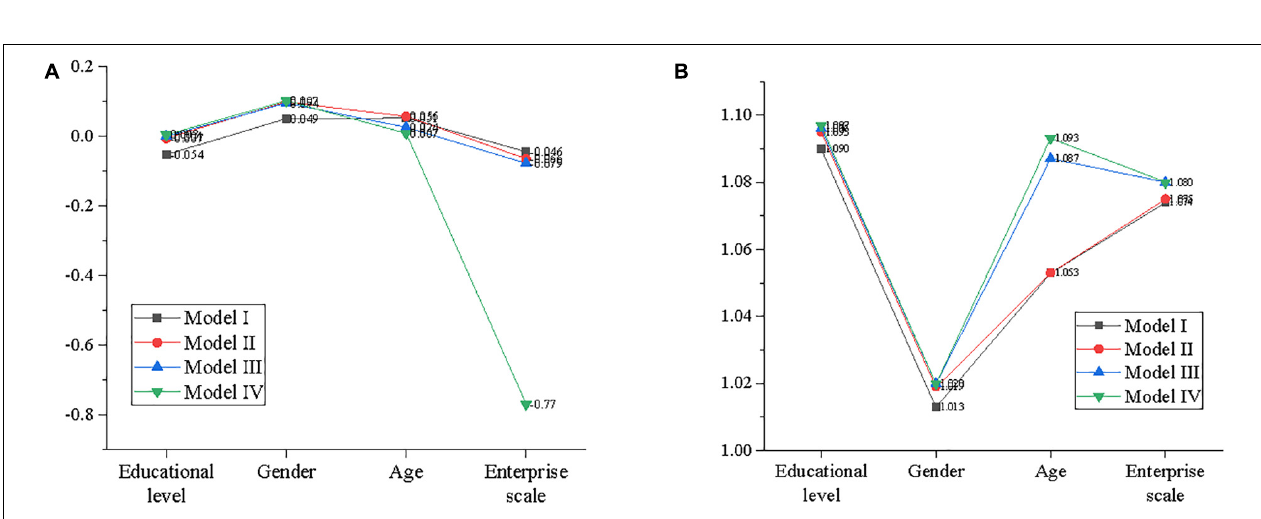
FIGURE 10 | Regression analysis of the moderating effect of continuance commitment on model innovation and entrepreneurial behavior. (A) Beta value, (B) variance inflation factor (VIF) value.